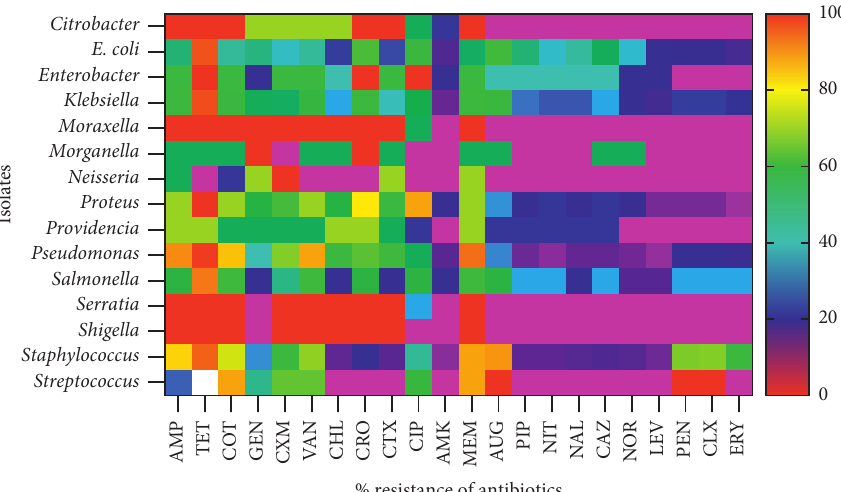
Figure 1: Heat map showing phenotypic antibiotic resistance pattern of bacteria at Bolgatanga Regional Hospital, January 2018–July 2020.